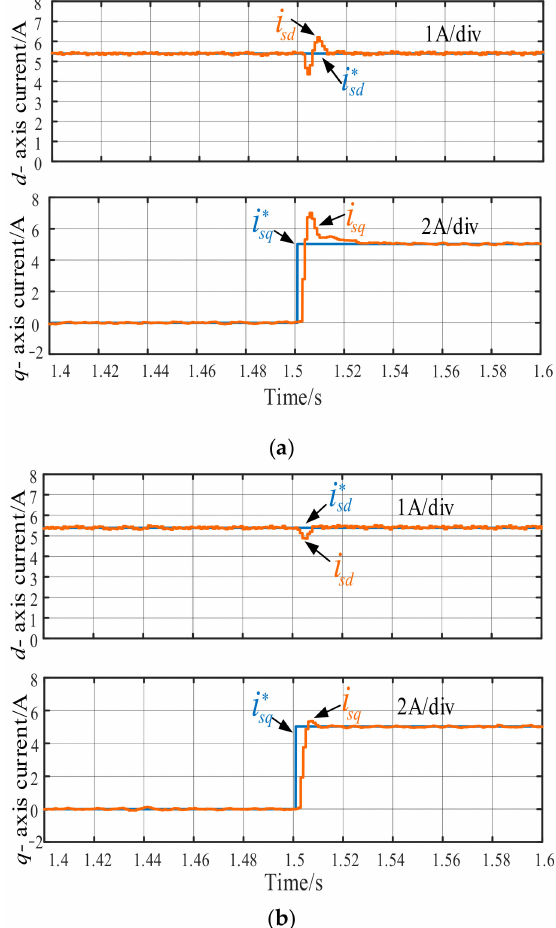
Figure 24. Step response of currents: ( a ) Feed-forward controller with delay compensation; ( b ) Improved complex vector control.